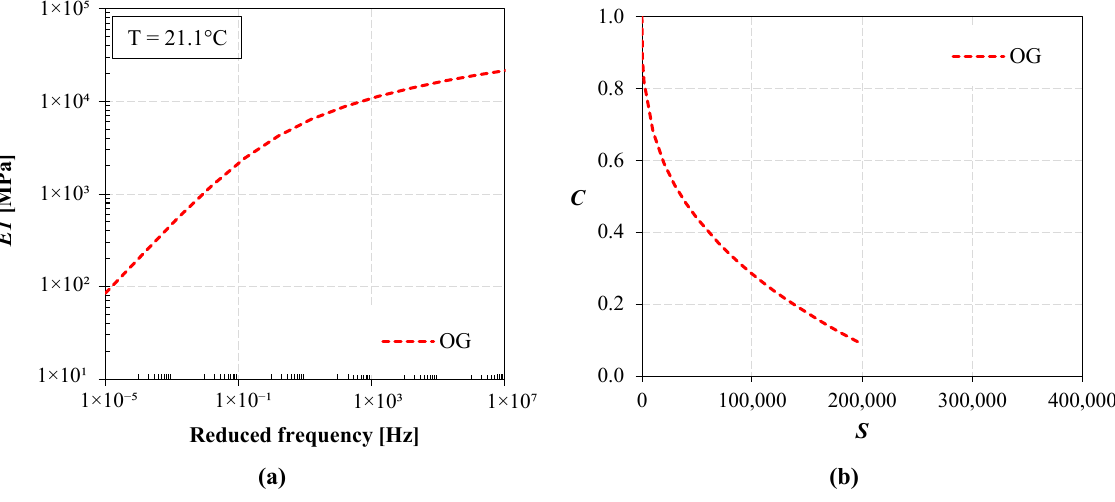
Figure 5. Properties of the OG mixture: ( a ) storage modulus master curve (2S2P1D model), ( b ) damage characteristic curve.